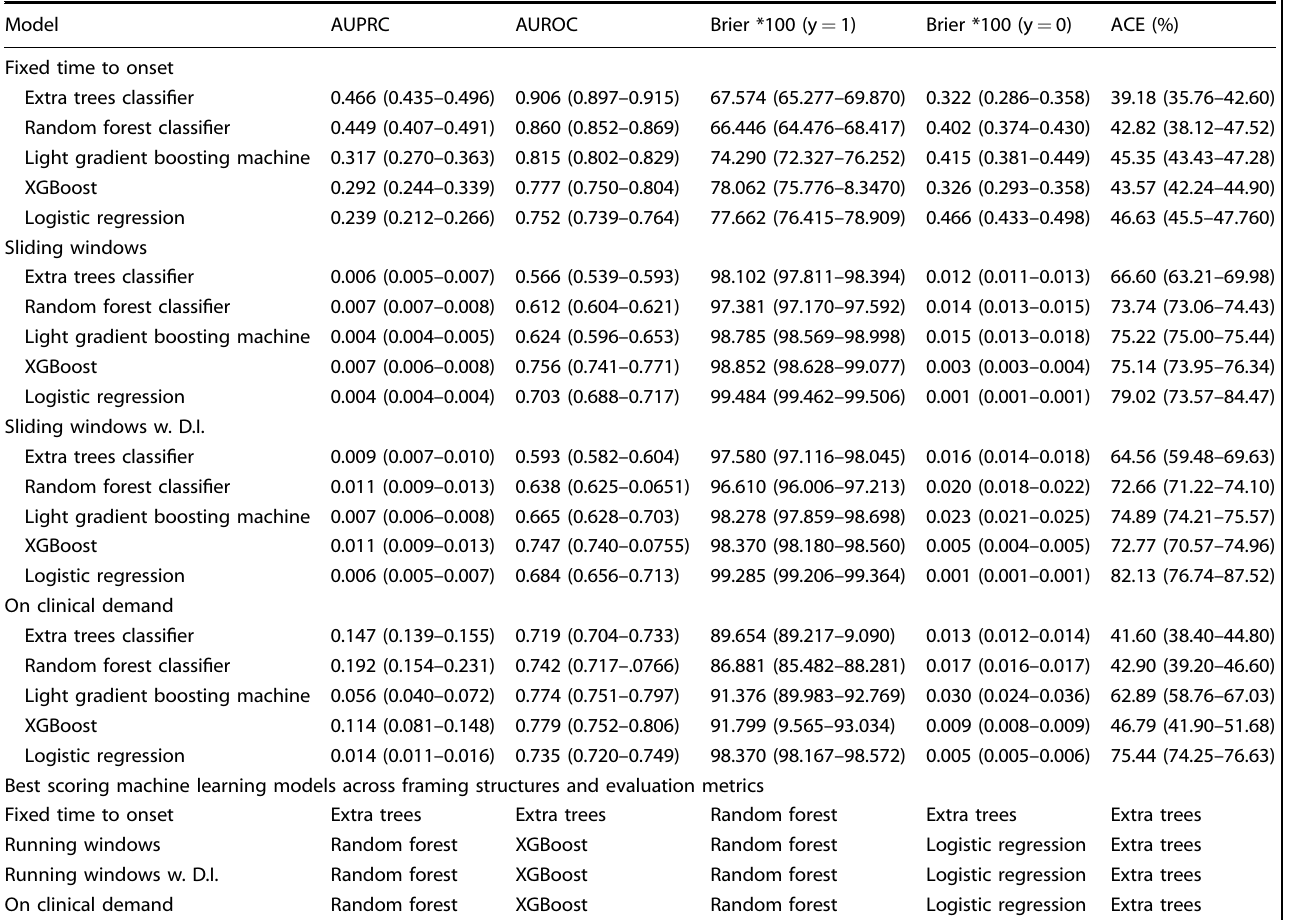
Table 2. Evaluation results (mean values and 95% con fi dence intervals in